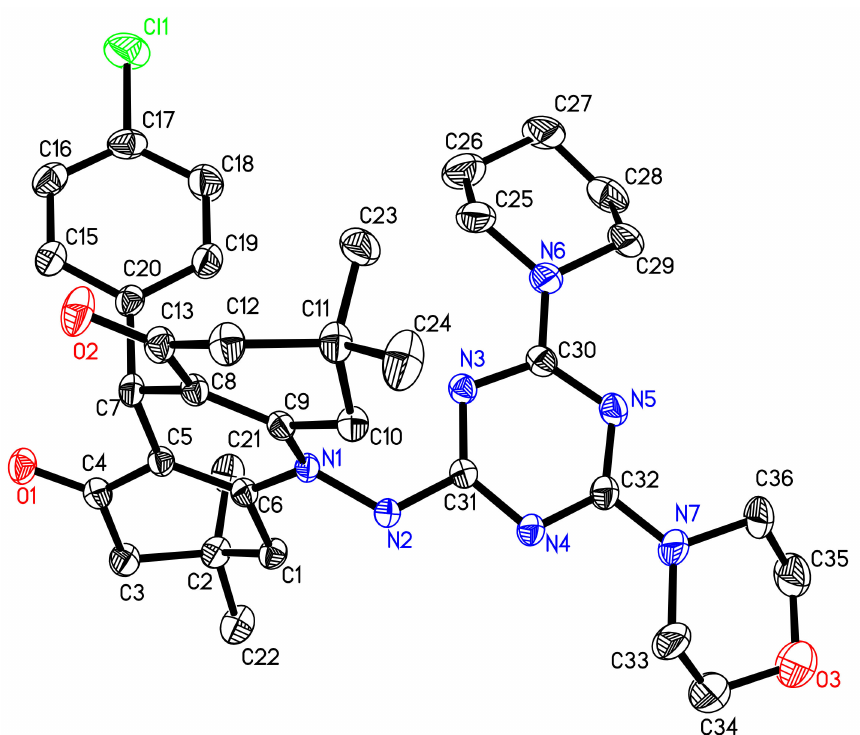
Figure 1. The ORTEP view of compound 4 showing atom numbering drawn at 50% probability level. H atoms have been omitted for clarity.